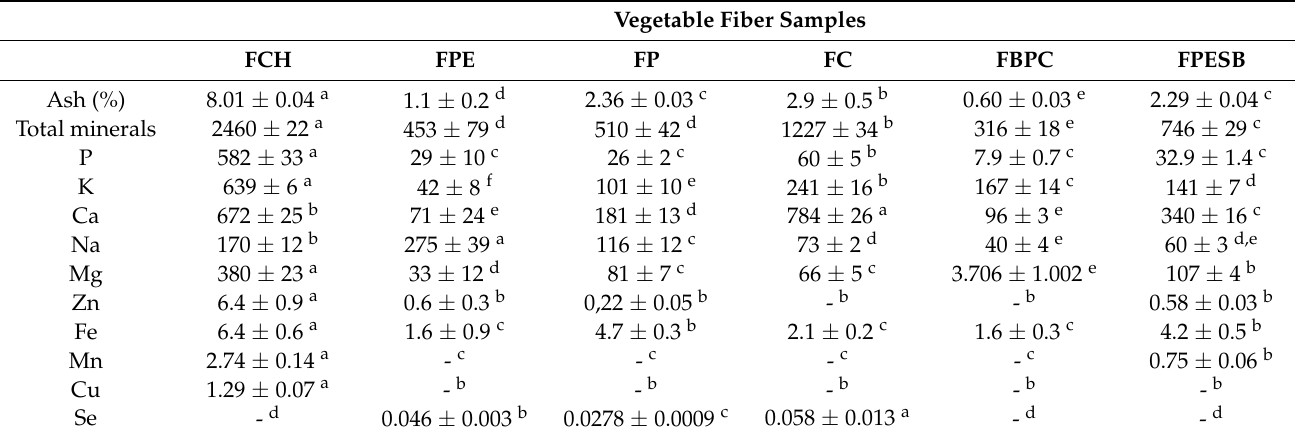
Table 3. Mean values ± standard deviations of ash (%), total minerals (mg/100 g sample) and mineral content (mg/100 g sample). Vegetable Fiber